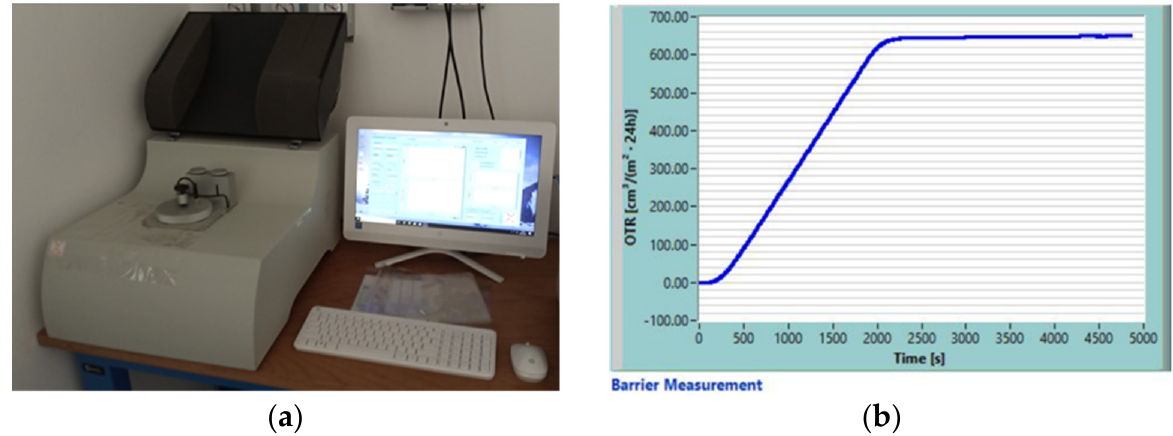
Figure 2. Set-up for gas permeability testing ( a ) and experimental “permeated gas volume-time” curve extrapolated from oxygen permeability test ( b ).